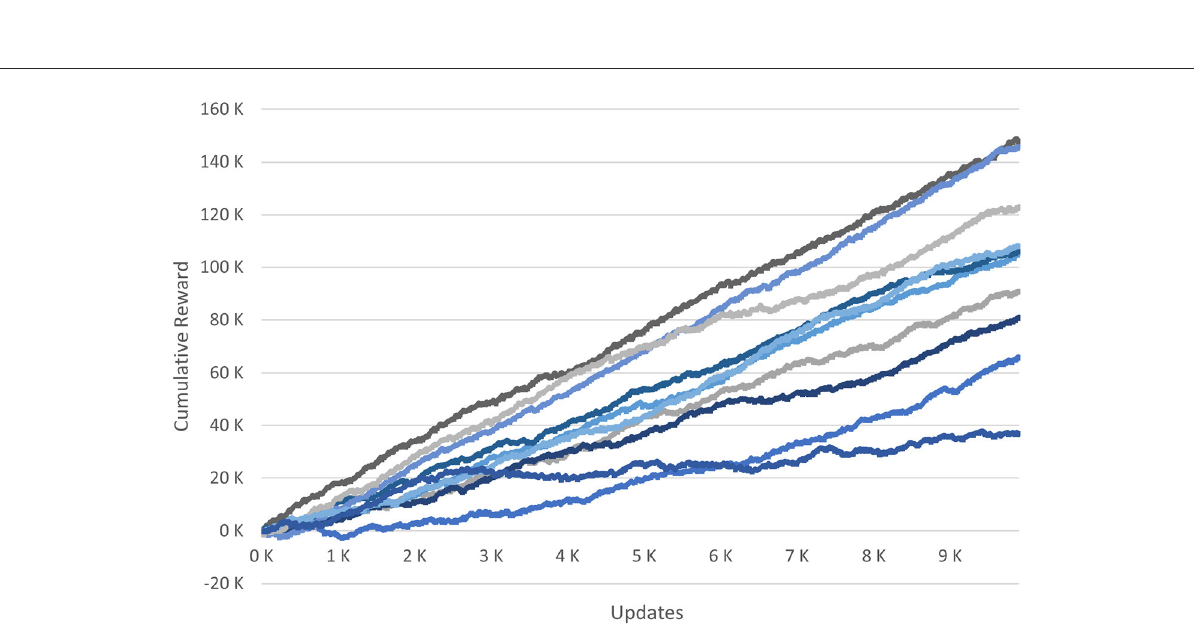
FIGURE6 Ten-fold cross-validation for the cumulative reward.